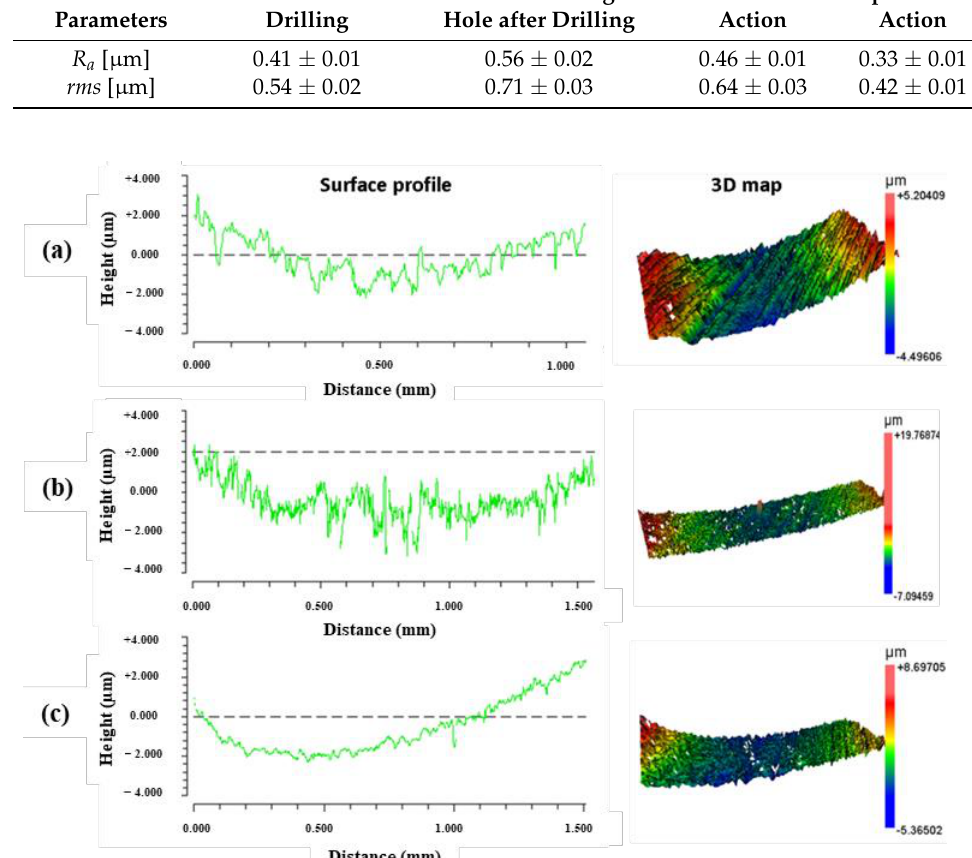
Figure 3. 2D surface profile and 3D map around the untreated hole ( a ) reinforced by nanosecond ( b ) and picosecond laser ( c ) treatment.